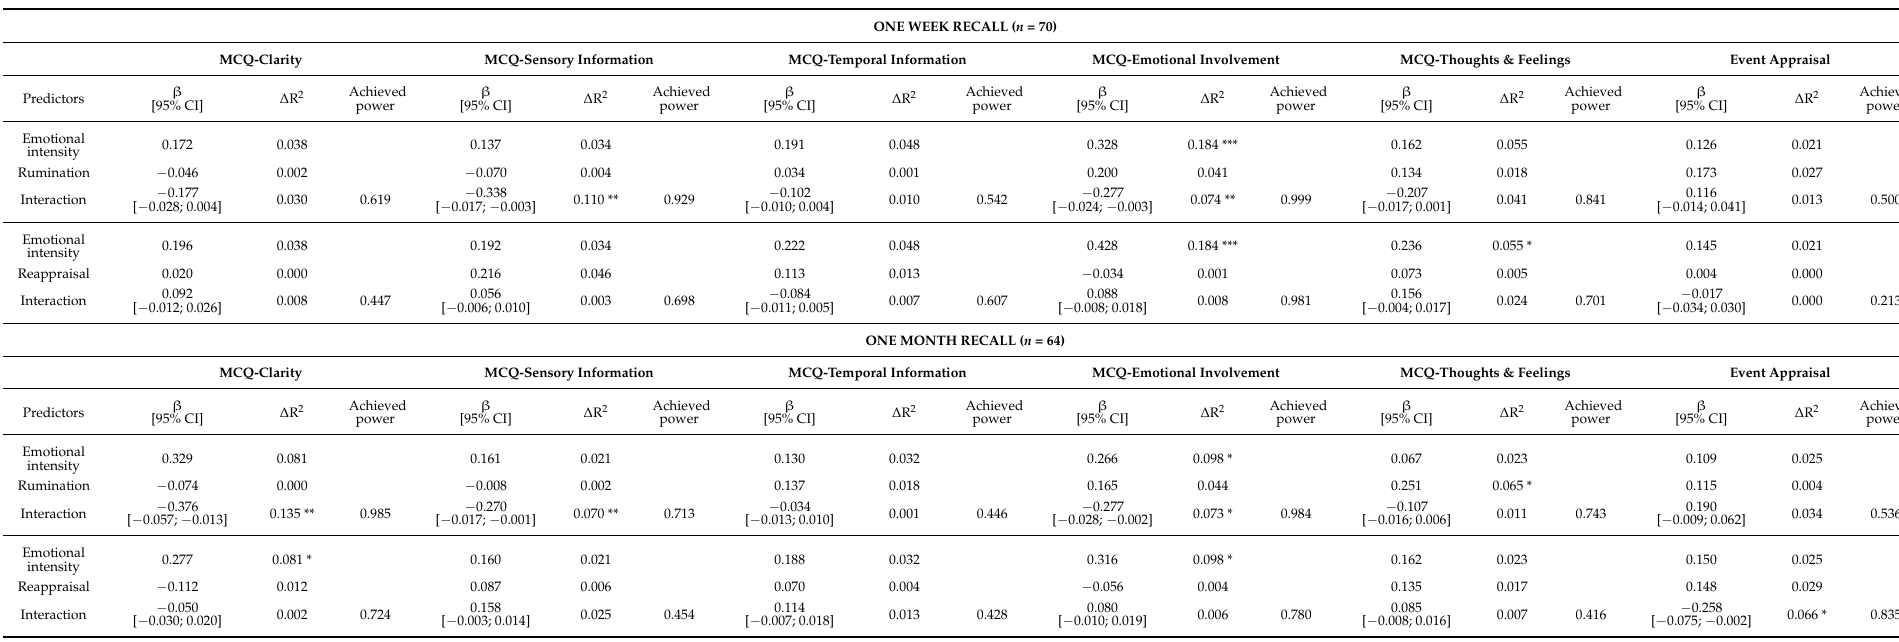
Table 2. Multivariate linear regressions predicting autobiographical memory characteristics. The Betas are from the last step of the regression equation. All predictors were centered. Post-hoc achieved power was calculated using